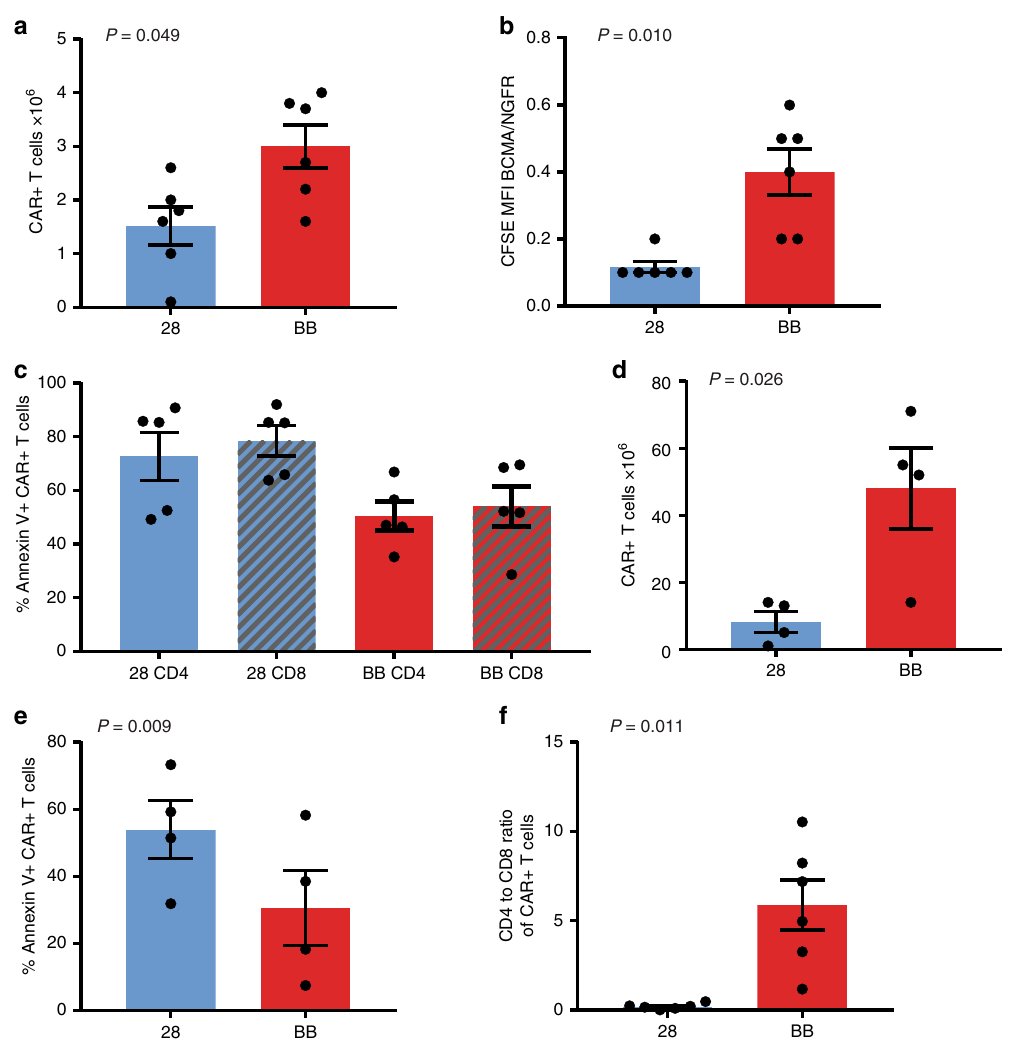
Fig. 5 4-1BB versus CD28 CARs: proliferation and survival. a T cells expressing FHVH33-CD828Z (28) or FHVH33-CD8BBZ (BB) were labeled with CFSE and cultured with irradiated BCMA-K562 cells or NGFR-K562 cells. Changes in CAR + T-cell numbers during the 4-day culture are shown ( n = 6). All